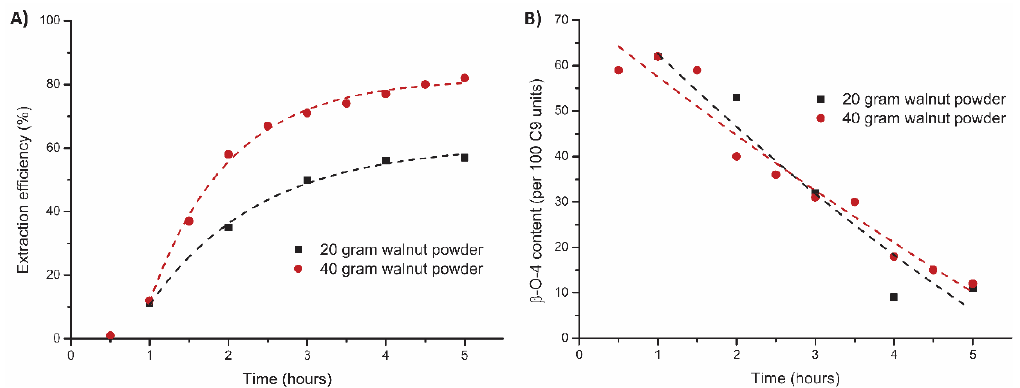
Figure 7. Influence of reactor loading on the mild organosolv extraction (95:5 EtOH / H 2 O, 0.18 M H 2 SO 4 , 120 °C, 5 h) on ( A ) extraction efficiency (corrected for alcohol incorporation as determined by 2D HSQC) and ( B ) total β -O-4 content as determined by 2D HSQC.